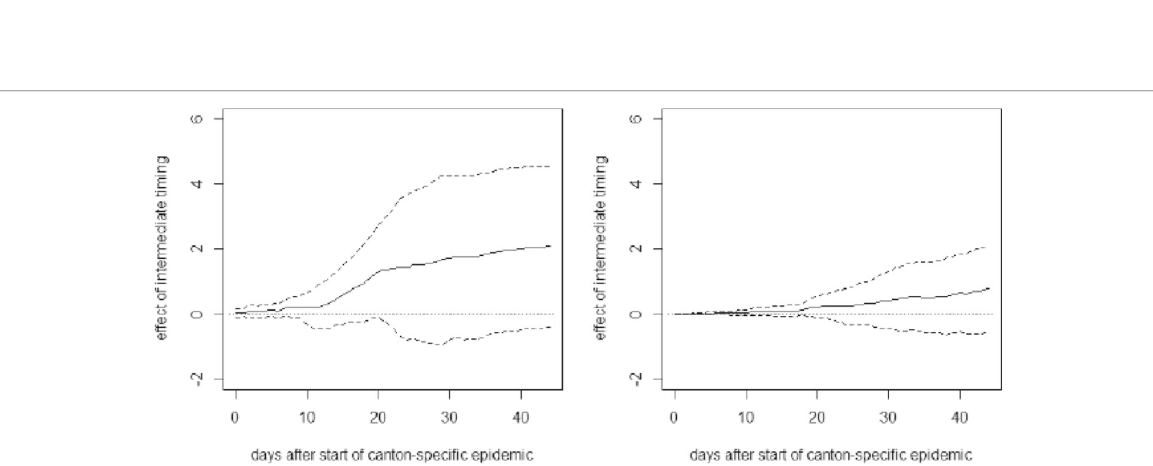
Fig. 16 OLS effect of intermediate timing of measures on cumulative hospitalizations (left) and deaths (right) per 10,000 inhabitants with covariates including